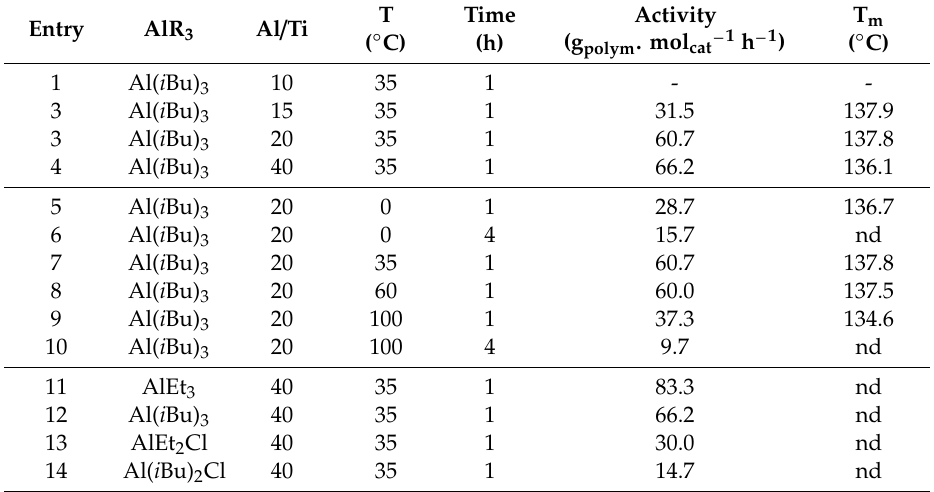
Table 11. E ff ect of the reaction conditions on the ethylene polymerization catalyzed by 32 / AlR 3 systems